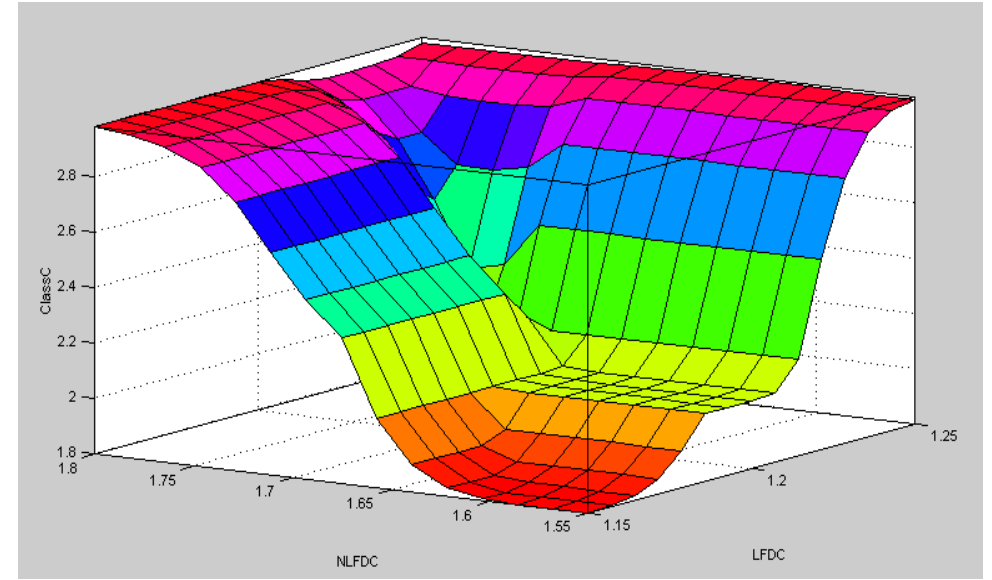
Figure 10. Nonlinear surface definitions for the classes by the fuzzy fractal model.